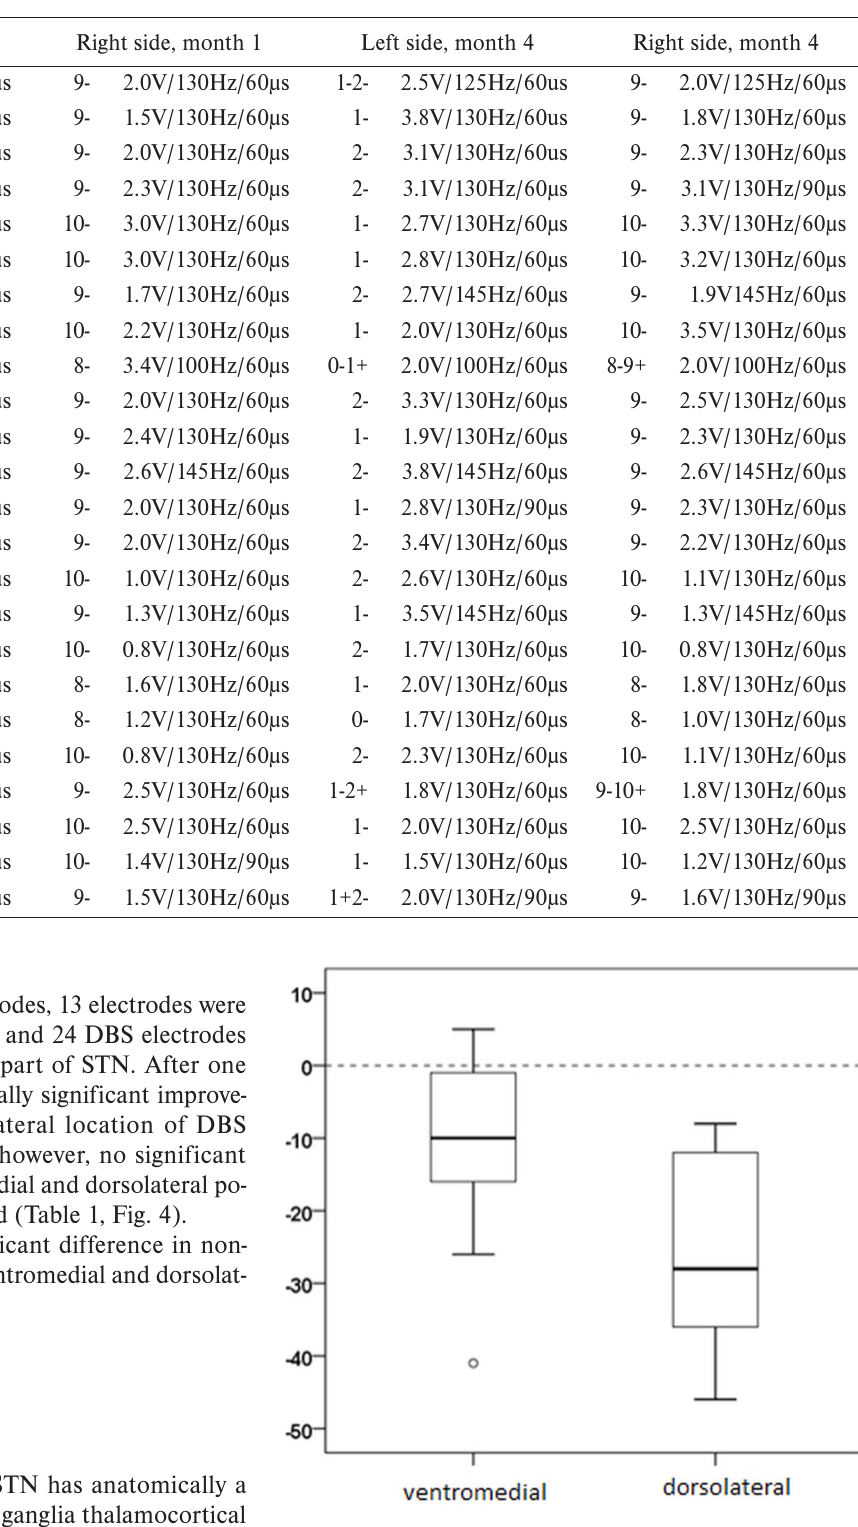
Table 3. Stimulation parameters after primary programming (month 1) and after four months (month 4) for each patient (active contact or contacts on the first row followed by intesity/frequency/pulse width).